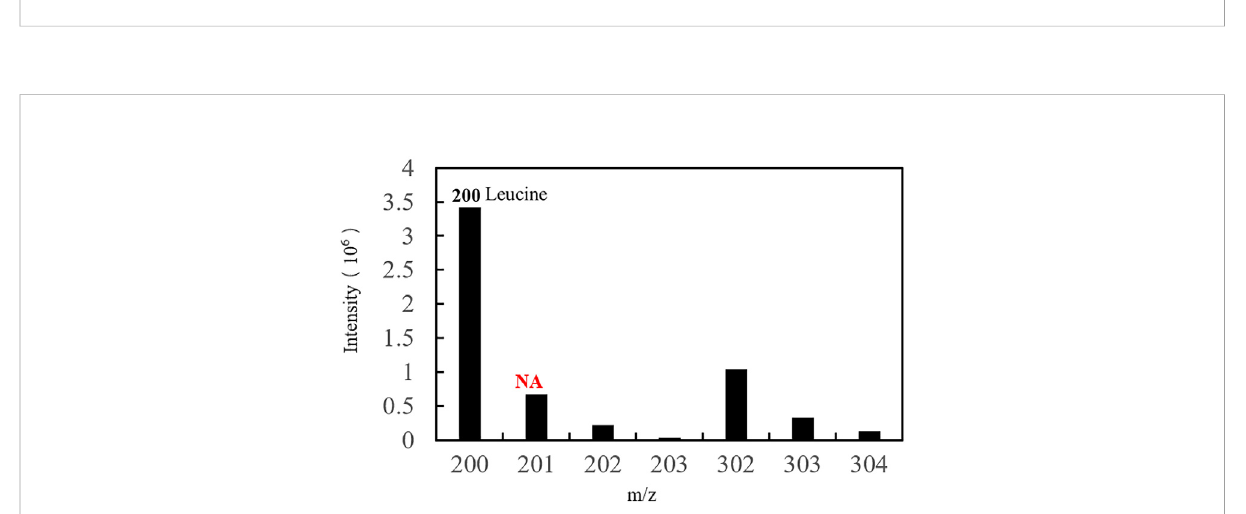
FIGURE 9 EI diagram of the embryo during organogenesis. Natural abundance (NA).